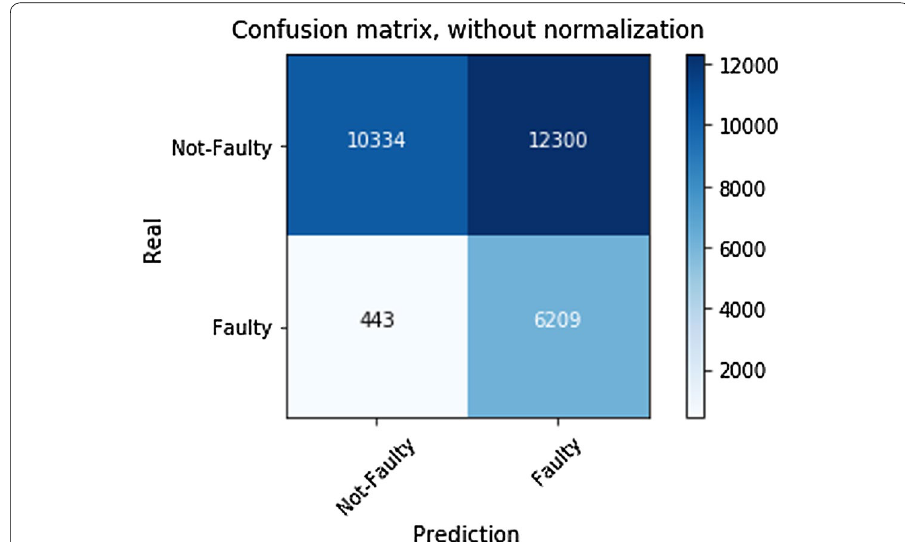
Fig. 10 Confusion matrix (0.3)